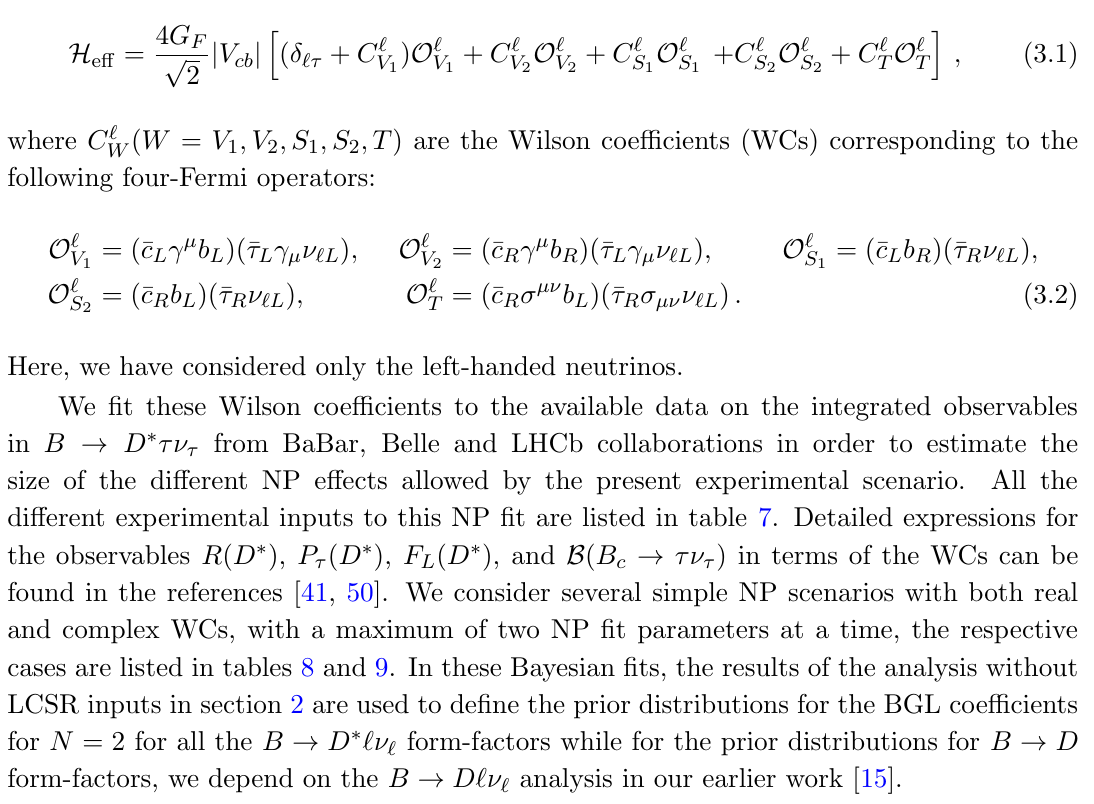
transitions is given by (cid:28)